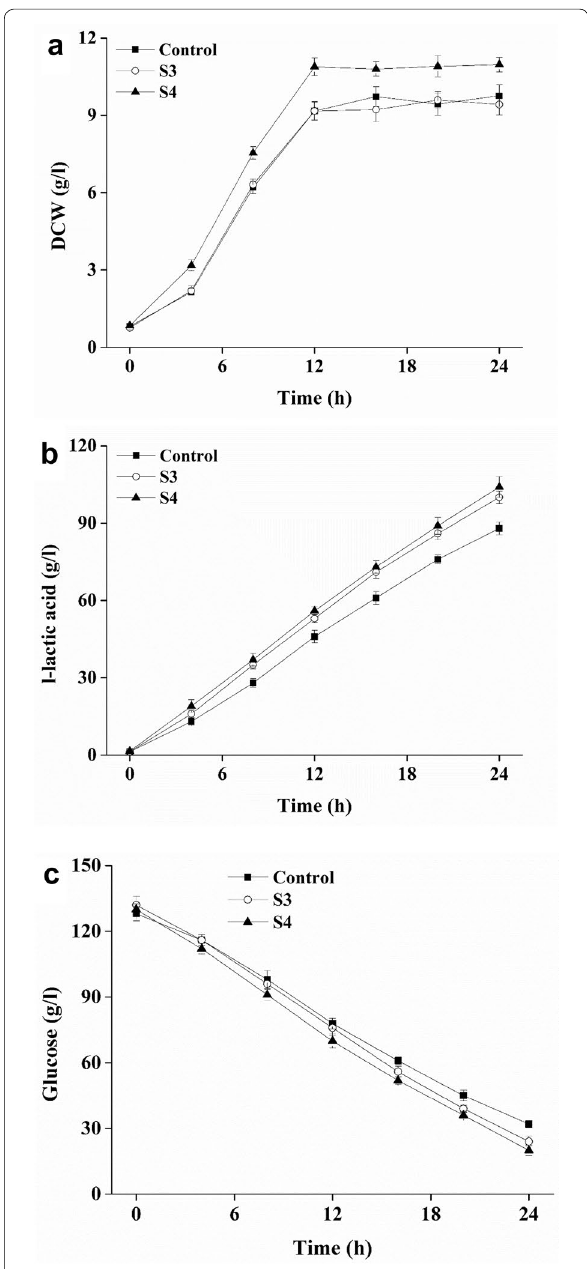
Fig. 9 Time profiles of cell growth, l -lactic acid production, and glu- cose consumption in the parent strain and the mutants of L. paracasei S3 and S4 cultures with a 5-l